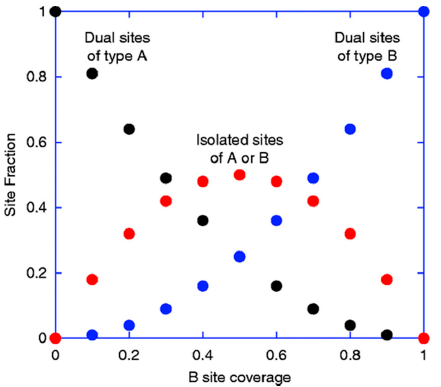
Figure 20. The variation of dual sites and single sites as a function of coverage of type B on the surface. Image adapted from M. Bowker et al. , Catal. Struct. React. , 2015 , 1 , 95–100 [36]. DRIFTS studies on 6ML (monolayers) MoO x /Fe 2 O 3 calcined at 600 °C, have been carried out by the